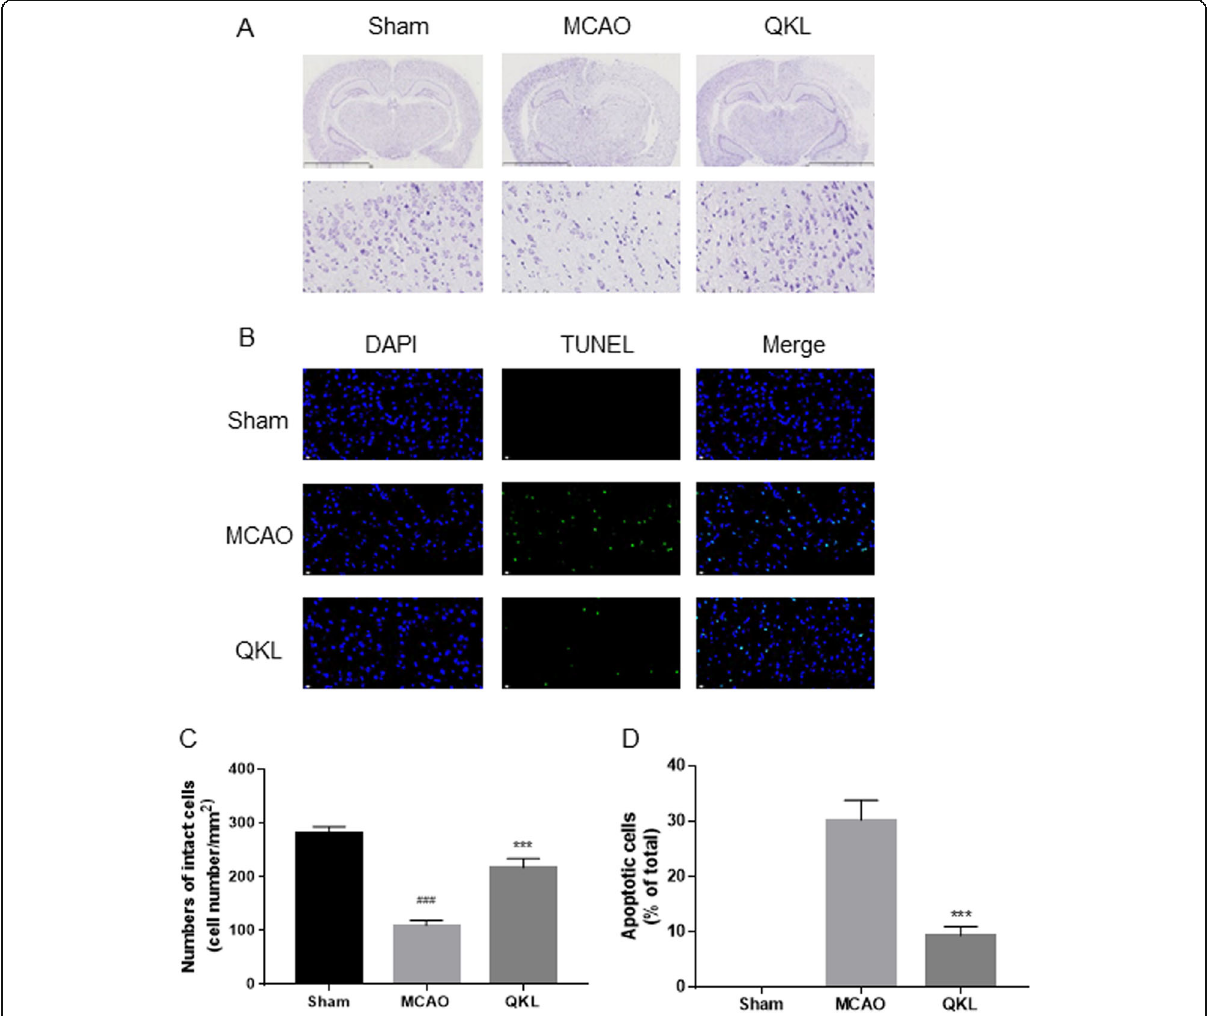
Fig. 3 Anti-apoptosis effects of QKL. a Representative pictures of Nissl staining and b representative images of cell apoptosis stained with the TUNEL method. c Relevant quantitative analysis of intact cell number and d rate of apoptotic cells in each group. Data points indicate means ± SEM. Vs Sham group, ### < 0.001, Vs MCAO group, *** p < 0.001. At least three independent experiments were performed for each